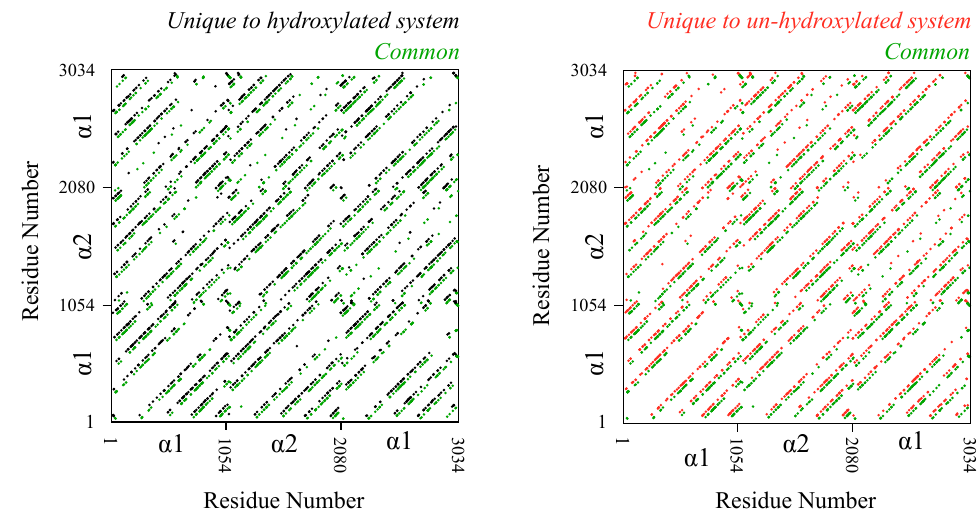
Figure 3. Effect of de-hydroxylation on residue pairwise contacts between monomers. Each inter- monomer contact is shown as a dot. Contacts common to the hydroxylated and un-hydroxylated systems are shown in green. Contacts unique to the hydroxylated system are shown in black, and those unique to the un-hydroxylated system are shown in red. Note that for the sake of clarity, the superimposed unique and common contacts are slightly shifted with respect to each other. Without the shift, diagonal patterns lie on top of each other. α 1 and α 2 refer to the two chain types in the triple